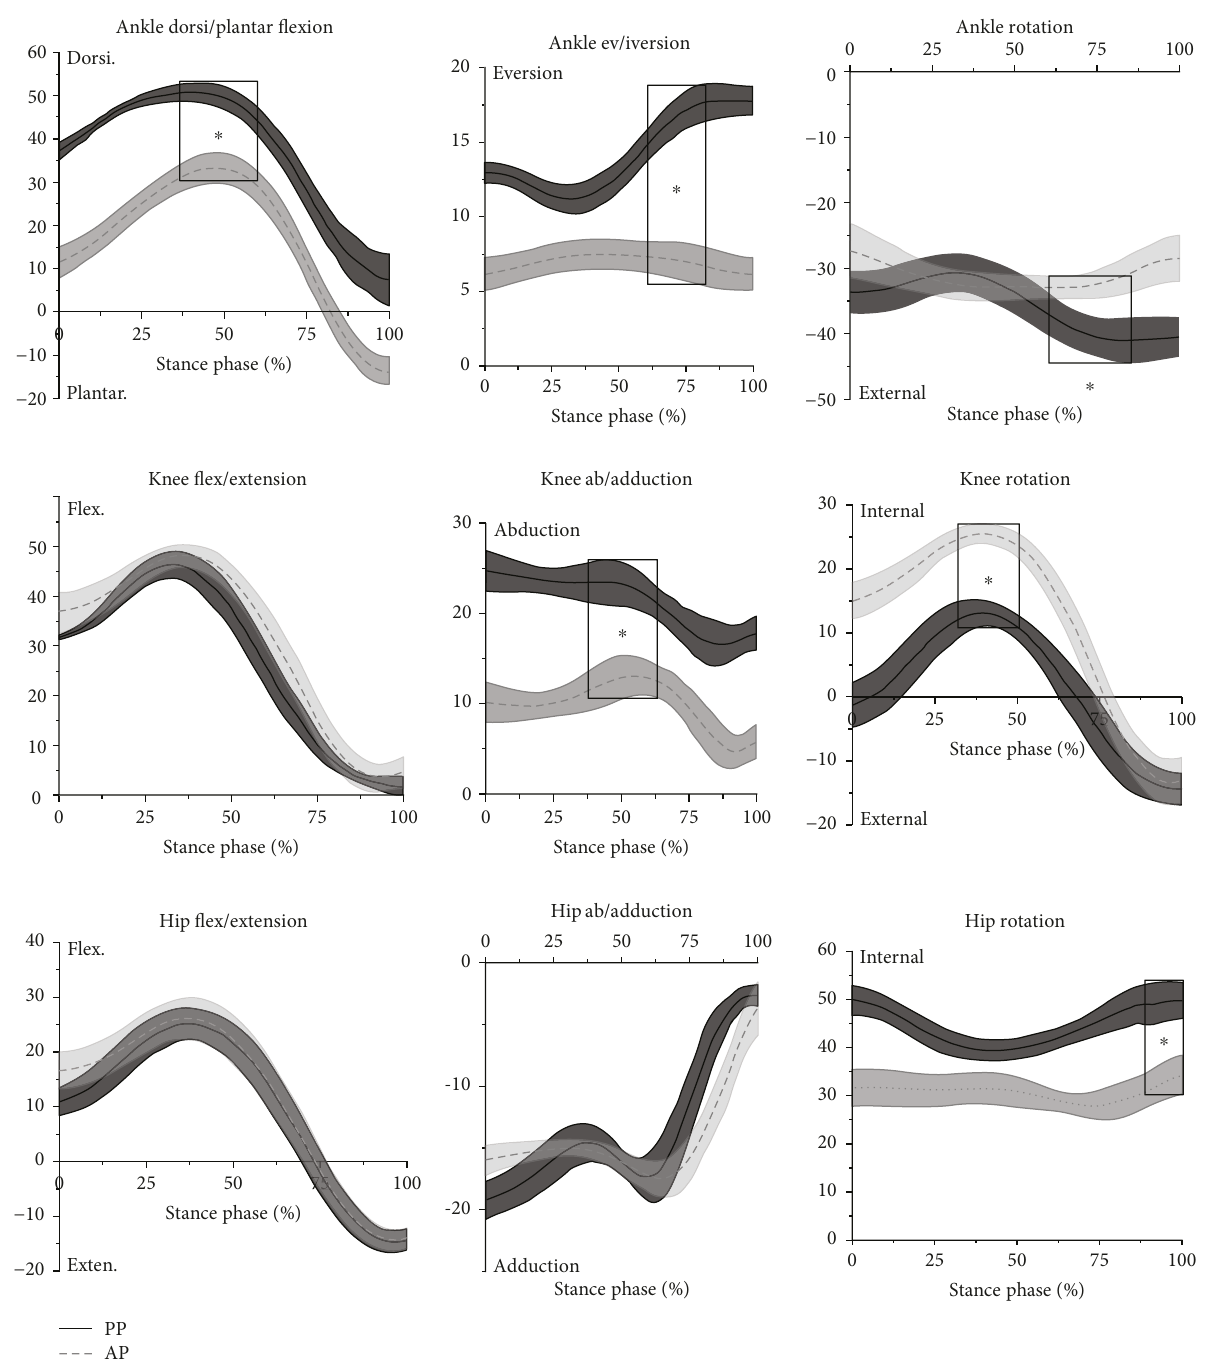
Figure 4: The kinematics of the right lower limb during the stance phase of the forehand overhead clear stroke (statistically signi fi cant results were highlighted with rectangles; ∗ P < 0 05